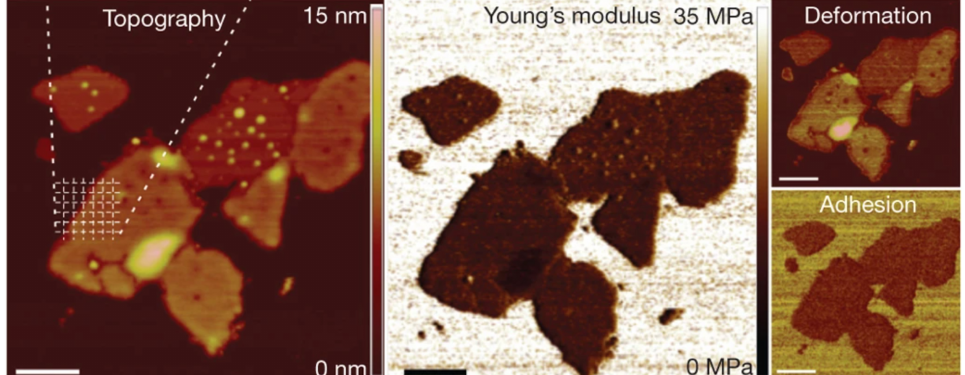
Figure 5. Mechanical property mapping of a native cytoplasmic purple membrane adsorbed on mica and imaged in a buffer solution with topography, Young’s modulus, deformation, and adhesion (adapted from [72] with permission, copyright 2013 Springer